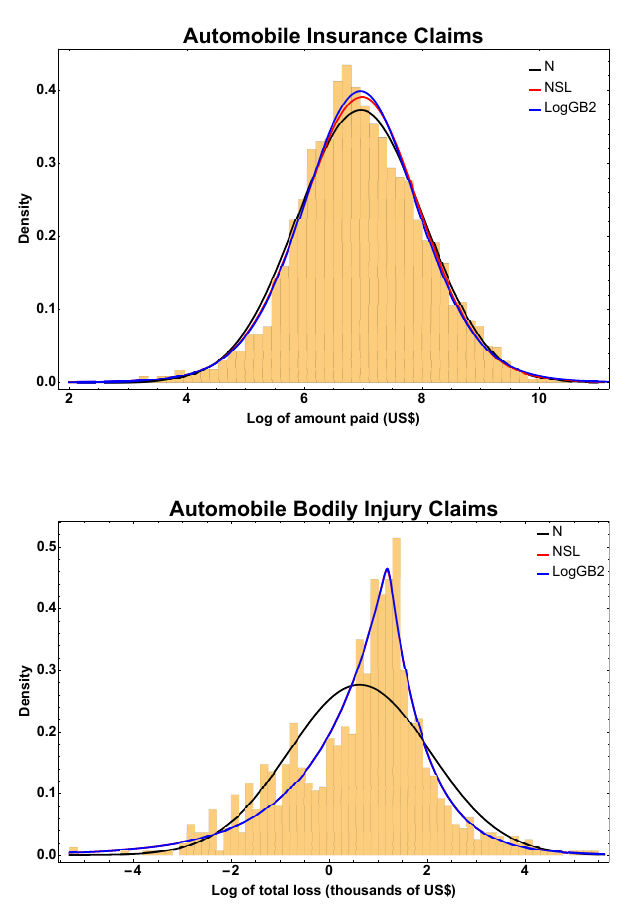
Figure 1. Empirical distribution of the logarithm of automobile insurance claims ( above ) and logarithm of automobile bodily injury claims ( below ). The log transformation of the LN (N, black), DPLN (normal skew-Laplace (NSL), red) and GB2 ( Log GB2, blue) distributions have been